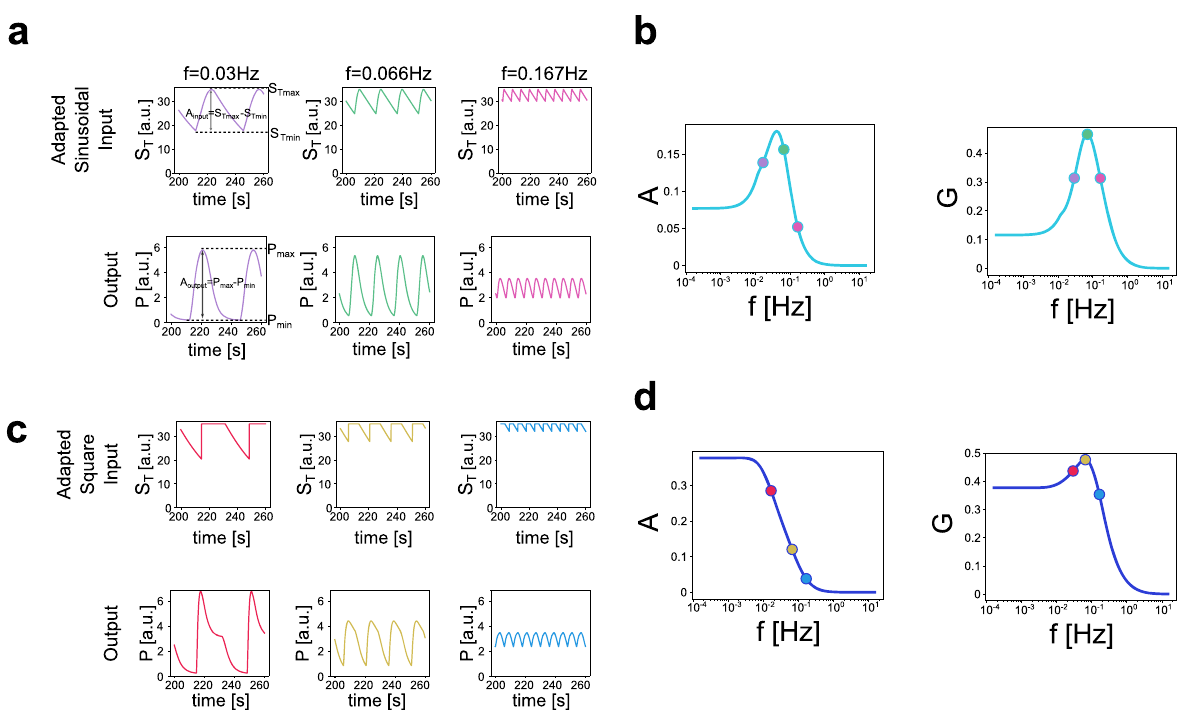
Fig. 5 Frequency-preference response in a CMC under periodic stimulation. a Representative time courses for adapted sinusoidal inputs S T (upper panels) with increasing frequencies and the corresponding outputs P (lower panels). For the three stimulation frequencies, the maximum reached by S T is 35, whereas the minimum depends on the frequency, being 17.72, 24.81, and 30.01, in the left, middle, and right panels, respectively. The CMC parameter values are those listed for Fig. 4a and the periods of stimulation are, 33.33, 15.15, 6 s in left, middle, and right panels, respectively, resulting in frequencies of 0.03, 0.066, and 0.167 Hz. b Frequency response results, measuring amplitude (left) and gain (right) as a function of the input frequency. The amplitude of the output is de fi ned as the difference between the maximum and the minimum values of P . The gain is the ratio between the amplitude of the output and that of the input. The three examples in a are indicated over the plot (same color code). c Representative time courses for the input S T (upper panels) and the corresponding outputs P (lower panels), corresponding to an adapted train of square pulses stimulation. For the three stimulation frequencies, the maximum reached by S T is 35, whereas the minimum depends on the frequency, being 20.3, 27.61, and 31.85 in the left, middle and right panels, respectively. Parameter values and input frequencies are as in a . d Frequency response results, measuring amplitude (left) and gain (right) as a function of the input frequency. The three examples in c are indicated over the plot (same color